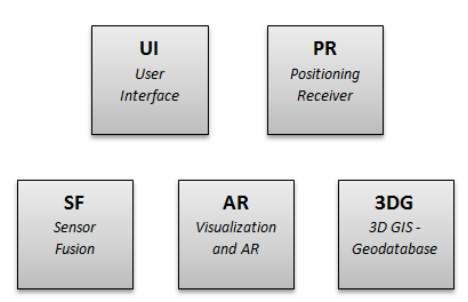
Figure 3: Logic view of LARA architecture